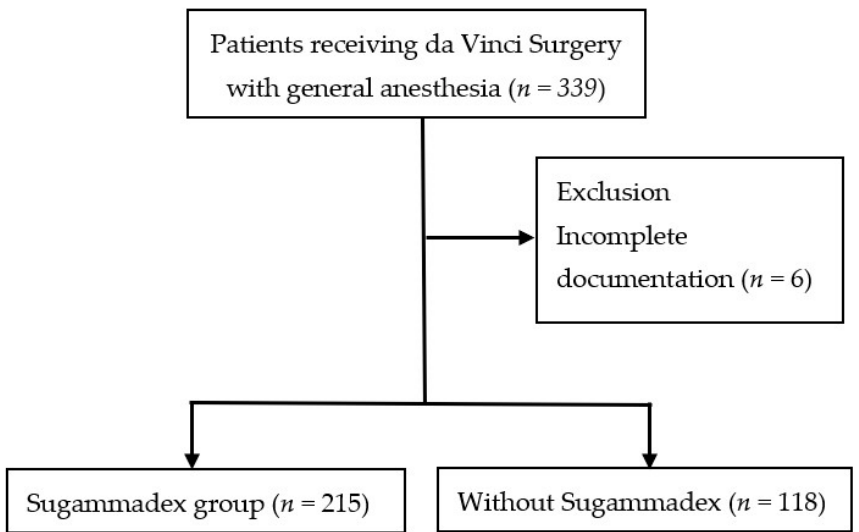
Figure 1. Flow diagram of study group.